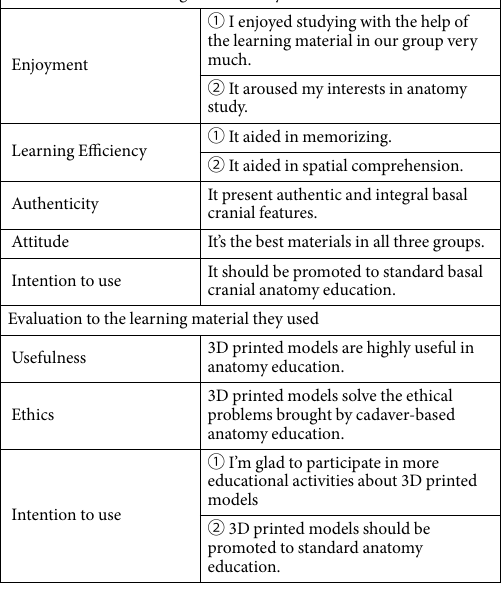
anatomy by a third-party non-investigator. During the lecture, cadaveric, 3D printed and 2D atlases of skulls were allocated to the three groups, respectively, with five to six participants using a single model or single set of atlas. Five cadaveric skulls, five 3D printed skulls, and five sets of 2D atlases were used. Each participant received a sin- gle printout of teaching materials for note-taking. After the introductory lecture, three groups were assigned to three separate rooms for a 30-min self-directed learning session using cadaveric skulls, 3D printed skulls and 2D atlases, respectively. Exam proctors were assigned to each room to prevent inter-group communication, and they would not answer questions of any participants nor provide any suggestions related to skull anatomy. Learning outcomes were evaluated by post-test immediately after self-directed learning session. All types of learning mate- rials were removed before commencing the post-test. After post-test, each participant finished a subjective eval- uation questionnaire. Additionally, participants in the 3D group completed another questionnaire to evaluate the 3D printed skull model.